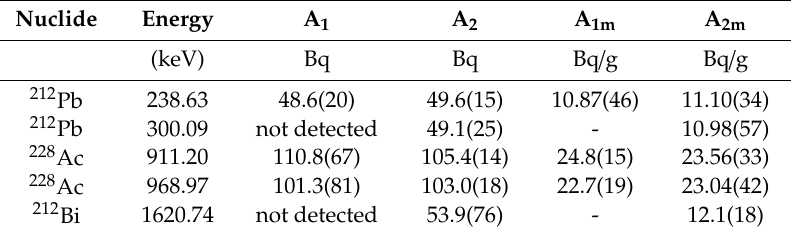
Table 4. Background corrected 228 Ra (from 228 Ac) and 224 Ra (from 212 Pb and 212 Bi) activities A 1 , A 2 and specific activities A 1m , A 2m (first and second sample, respectively). Combined standard uncertainties are shown in parentheses.